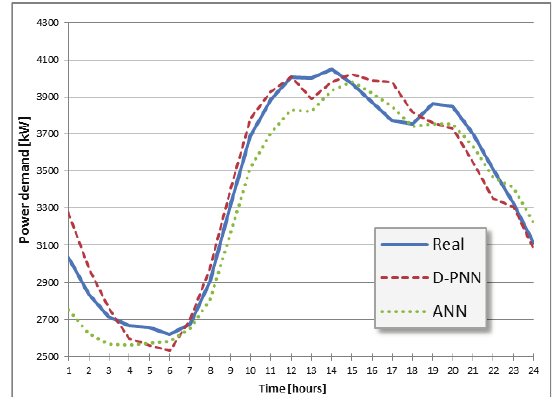
Fig. 9. TEPCO : 11.8.2012 (Saturday). D-PNN RMSE = 107.9 , ANN RMSE = 127.1